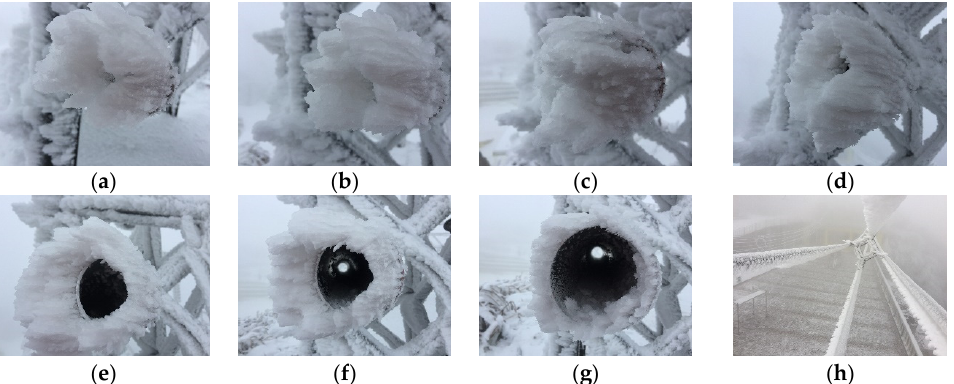
Figure 15. Icing picture of different diameter aluminum tubes and quad bundled conductors: ( a ) 40 mm, ( b ) 50 mm, ( c ) 60 mm, ( d ) 70 mm, ( e ) 80 mm, ( f ) 90 mm, ( g ) 100 mm, ( h ) quad bundled conductors [43].